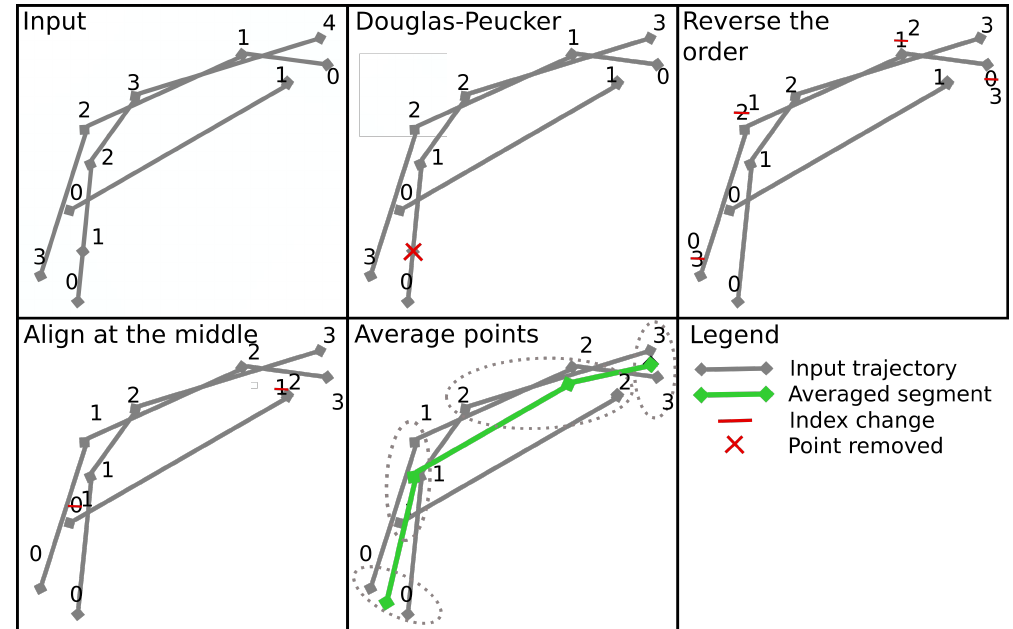
Figure 1. Visualization of the intermediate steps of the